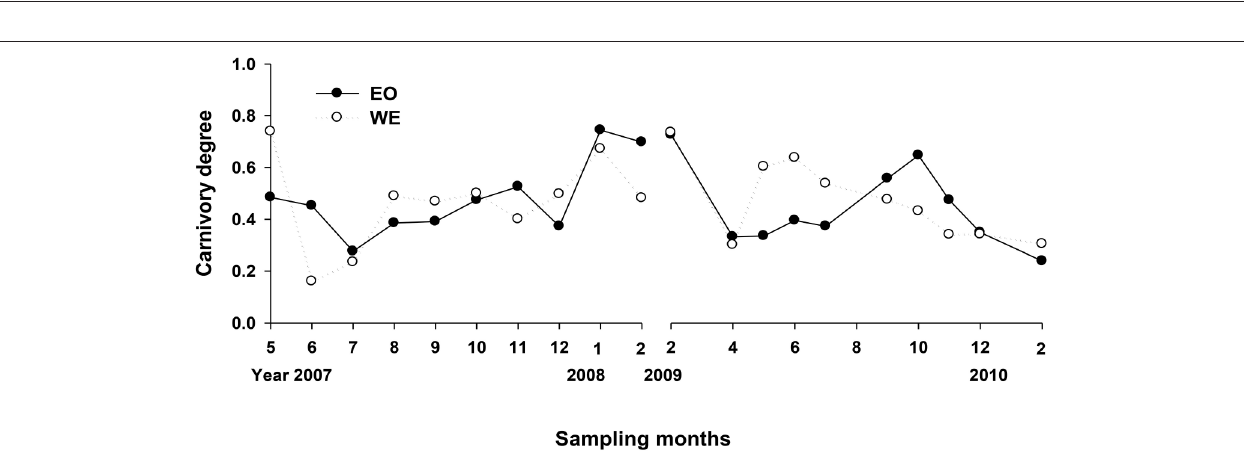
FIGURE 4 | Temporal variation in mesozooplankton carnivory